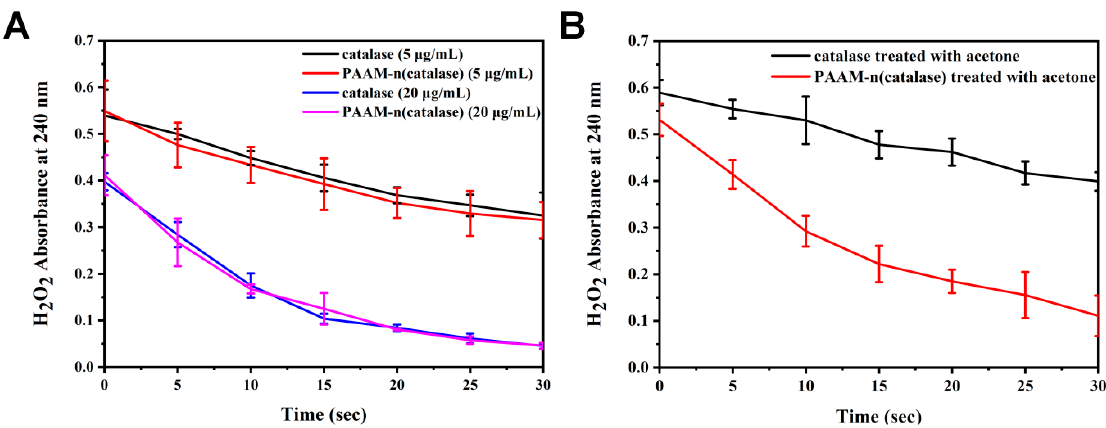
Figure 2. ( A ) The degradation kinetics of H 2 O 2 which were respectively treated with native catalase and PAAM-n(catalase); ( B ) native catalase and PAAM-n(catalase) were treated with acetone and their activities were tested by the degradation kinetics of H 2 O 2 .